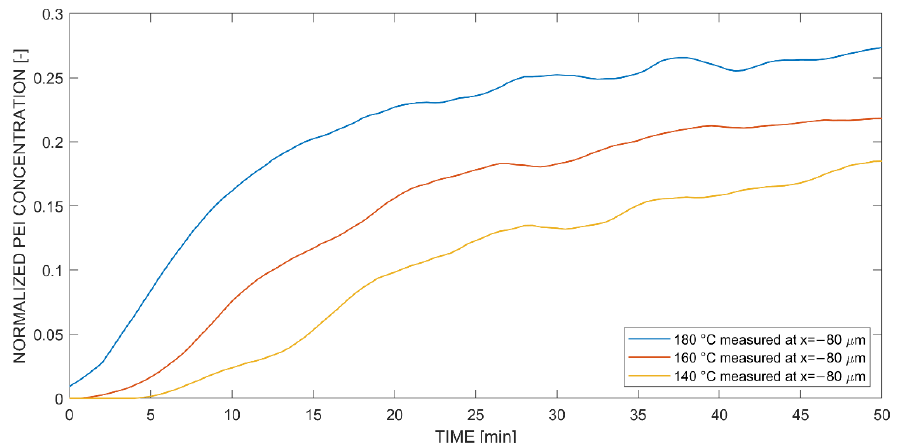
Figure 9. Temperature-dependent concentration curves normalized to Raman intensity amplitude 2437@1003 cm −1 at coordinate x = −80 μm (negative) for diffusion of the PEI into (monocomponent) epoxy precursor.